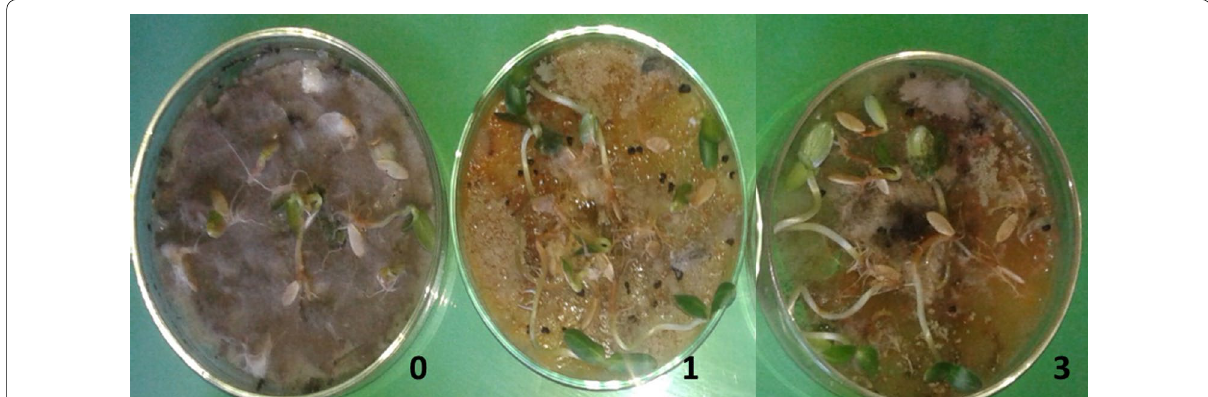
Fig. 3 Effect of nanoemulsion formulations (5000 ppm) of essential on pathogenic activity of B. cinerea on seed rot and seedling of cucumber 10 days at 27 2 °C. Fungal free treatment (0), fungal treatment with nanoemulsion of clove (1) and fungal treatment with nanoemulsions (2:1) of ± clove black seed oils +